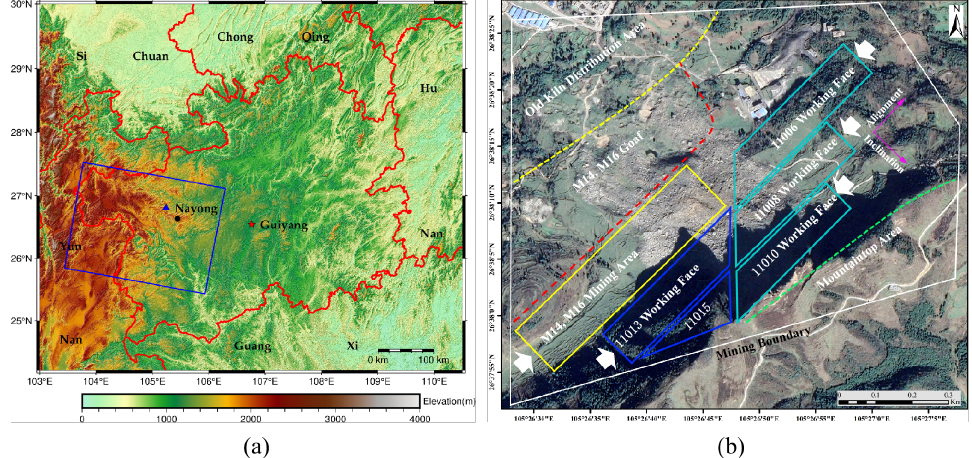
Figure 1. Geographical location and overview of the research area: ( a ) geographical location of study area; ( b ) overview of research